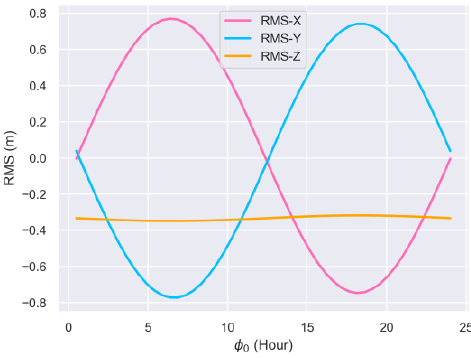
Figure 9 . The spatial position of observation data.